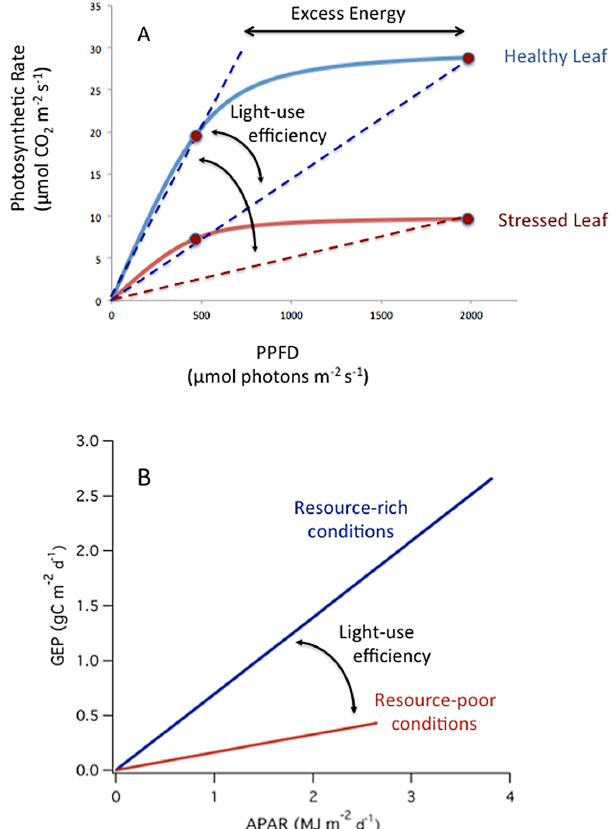
Figure 3. (a) Modeled photosynthetic light-response curves (rect- angular hyperbola) for healthy and stressed leaves, illustrating the decline in light-use efficiency (LUE), typically termed photon (or quantum) yield. (b) Stand-level light-response curves of gross ecosystem production (GEP) for different vegetation types having different moisture regimes, LUEs, and contrasting optical prop- erties. (a) Modified from Björkman and Demmig-Adams (1994). (b) Modified from Huemmrich et al.